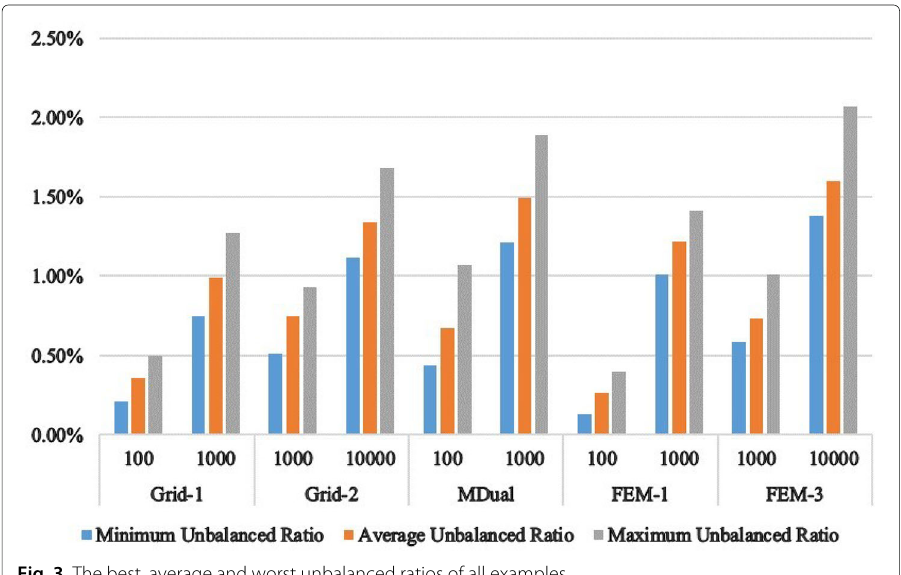
Fig. 3 The best, average and worst unbalanced ratios of all examples